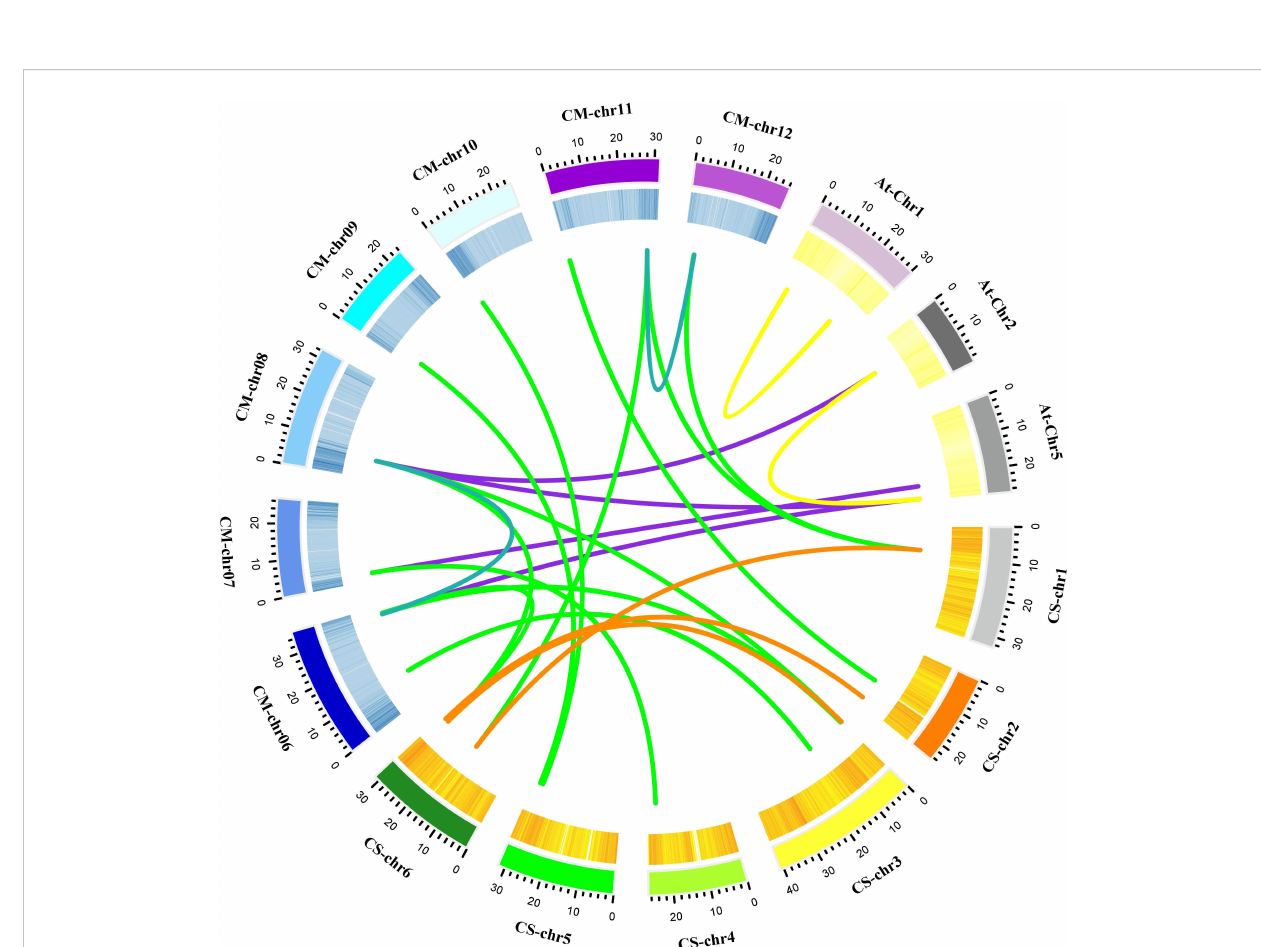
FIGURE 5 Collinearity analysis of the MLO gene family in melon. Different line colors indicate the following; green is showing homology between the melon and cucumber genomes; purple is showing homology between the melon and Arabidopsis genomes; blue is showing homology within the melon genome; yellow is showing homology within the Arabidopsis genome; and orange is showing homology within the cucumber genome. These gene pairs are connected by links between